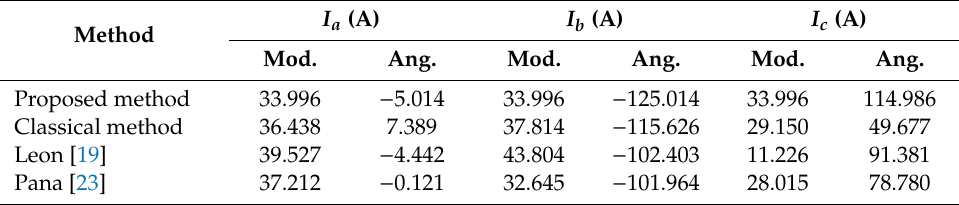
Table 8. Comparison of the proposed method with other existing methods.